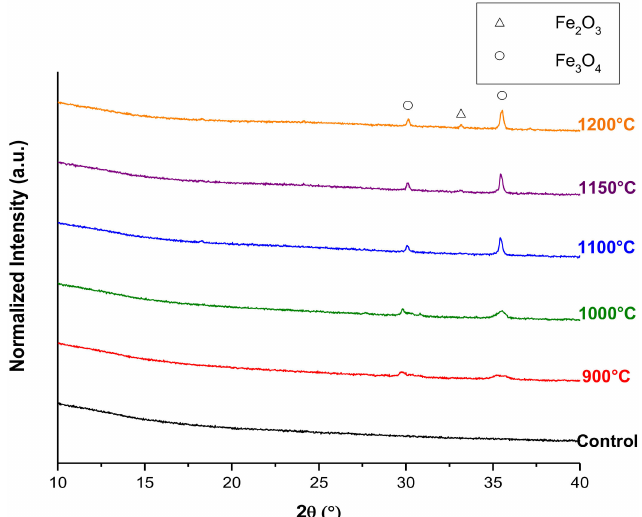
Figure 4. XRD plots for bulk volcanic ash glass heat treated for 1 h at 900, 1000, 1100, 1150, and 1200 ◦